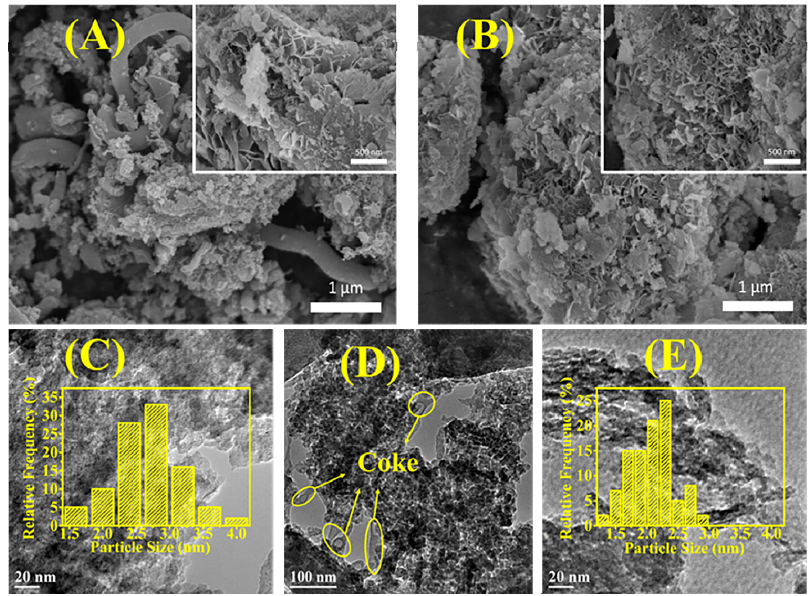
Figure 8. SEM images of spent catalysts: ( A ) PtInHTU, ( B ) PtInHTU-MgF 2 ; TEM micrographs of spent catalysts ( C , D ) PtInHTU, ( E ) PtInHTU-MgF 2